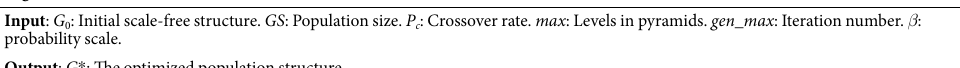
Algorithm 6: mlEA-C PD